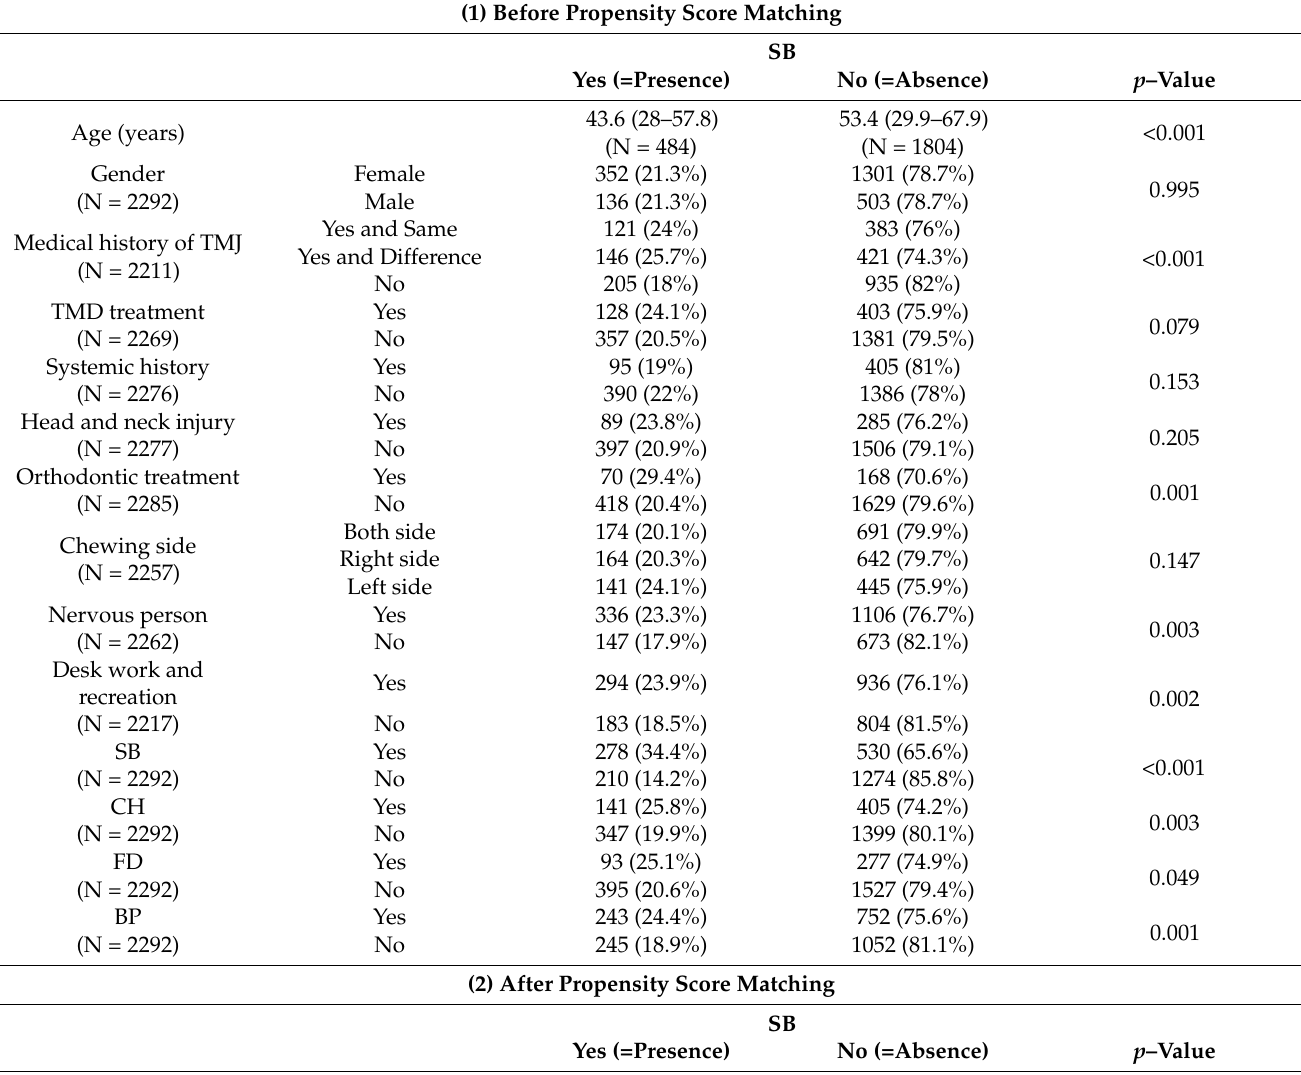
Table 2. Demographic and clinical characteristics of TMD patients with and without SB. (1) Before propensity score matching. (2) After propensity score